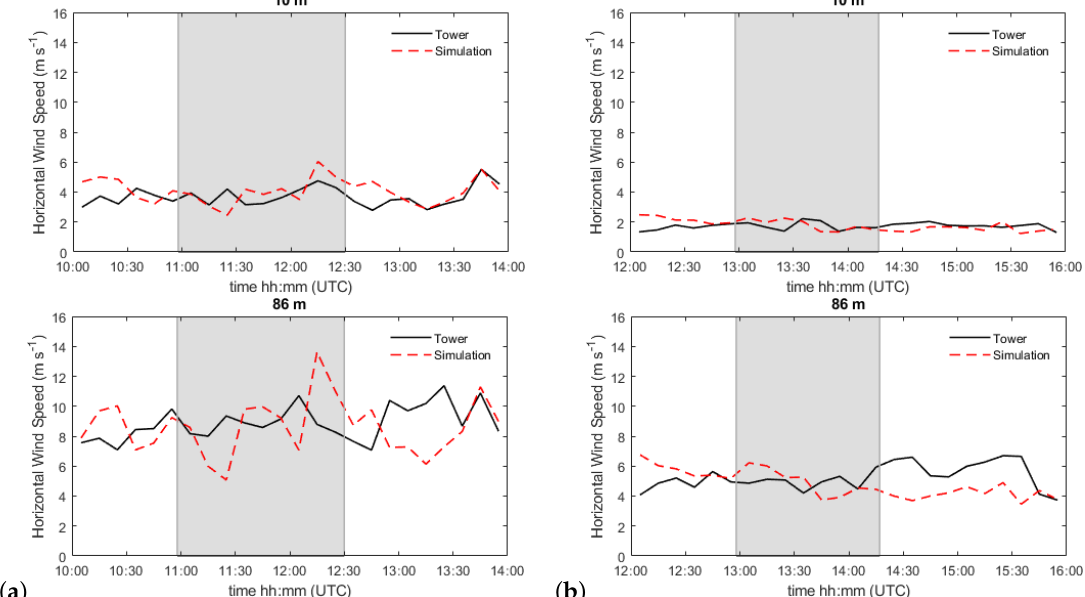
Figure 3. Time series of 10-min averages of horizontal wind speed at 10 m and 86 m on 21 ( a ) and 22 ( b ) September. The time series for the simulation (red) and the tower observations (black) are shown. The grey box marks the time flight period.